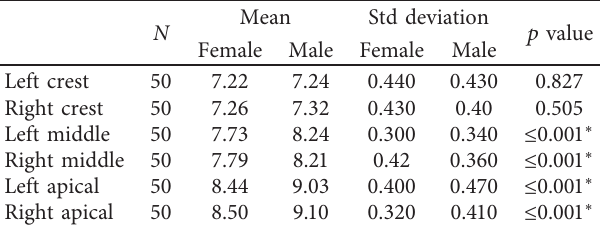
Table 2: Descriptive statistics of left and right alveolar bone thickness (mm) by gender with comparison of thickness between males and females according to side using t -test. N